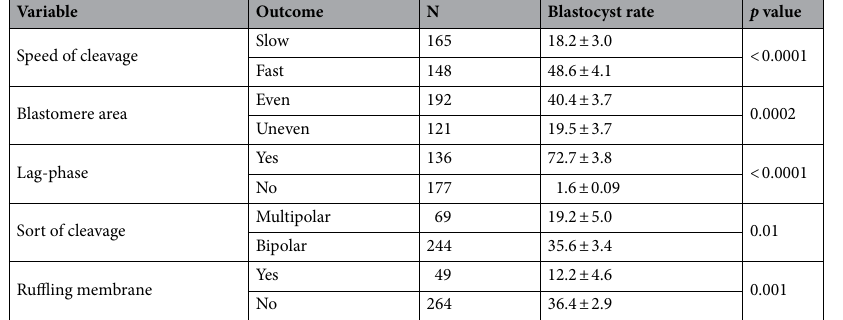
Table 4. Blastocyst rate based on different variables. n = number of zygotes/embryos analyzed. Blastocyst rate based on presence or absence of responsive variables. The speed of first cleavage is considered fast before or at 32 h and 22 min. Blastomere area is considered even when the difference is equal to or lower than 23.4%. Multipolar cleavage is defined as direct zygotic division into three or more cells. Results are stated as least square means ± standard